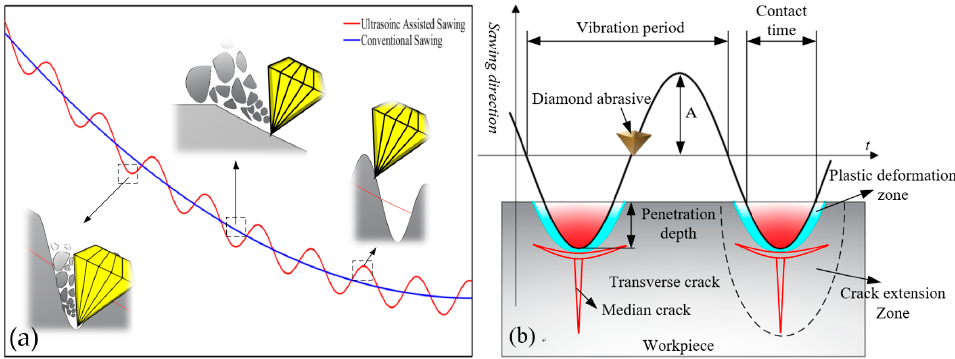
Figure 2. Simulation of an abrasive trajectory: ( a ) Movement track of abrasive grain during ultrasonic assisted sawing; ( b ) Cutting process of a single abrasive in the cutting arc area of ultrasonic sawing cutting.